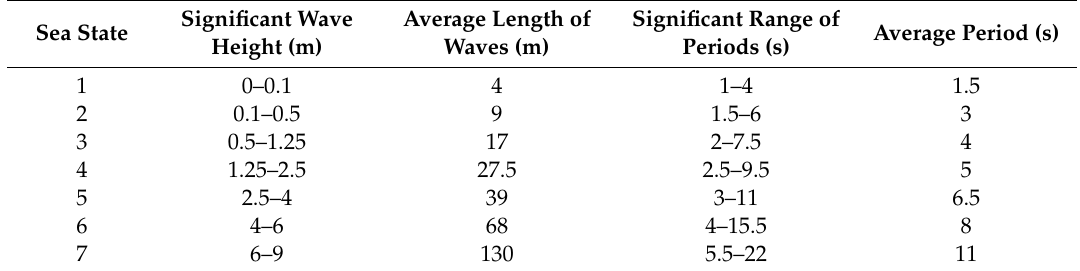
Table 1. Pierson–Moskowitz sea spectrum.